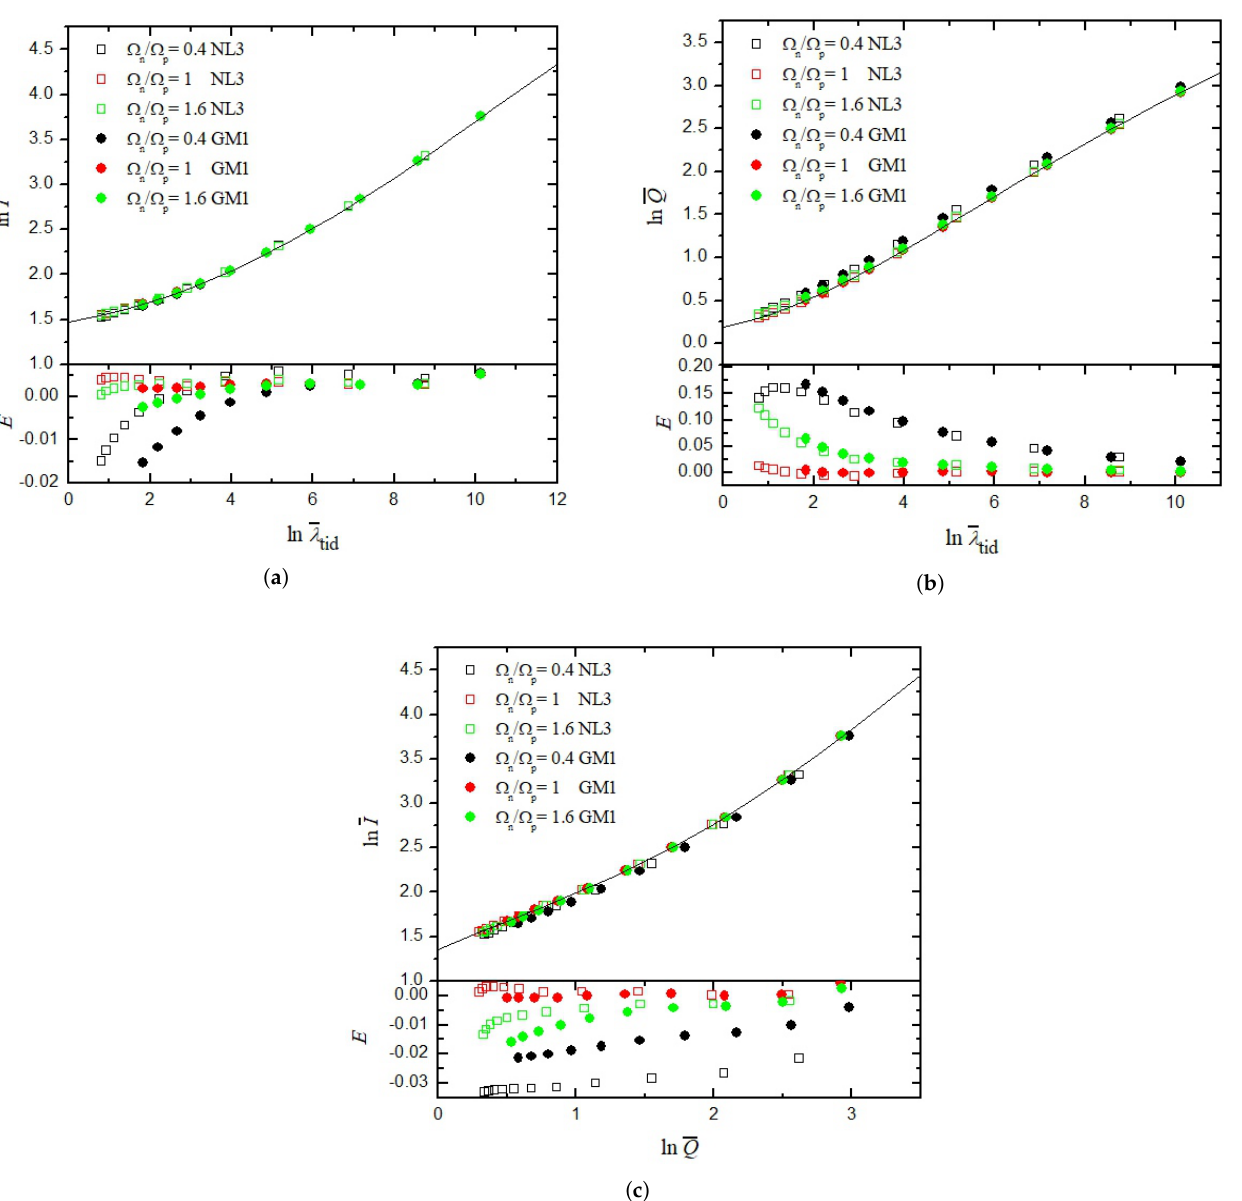
Figure 3. Similar to Figure 2, but for the GM1 and NL3 EOS